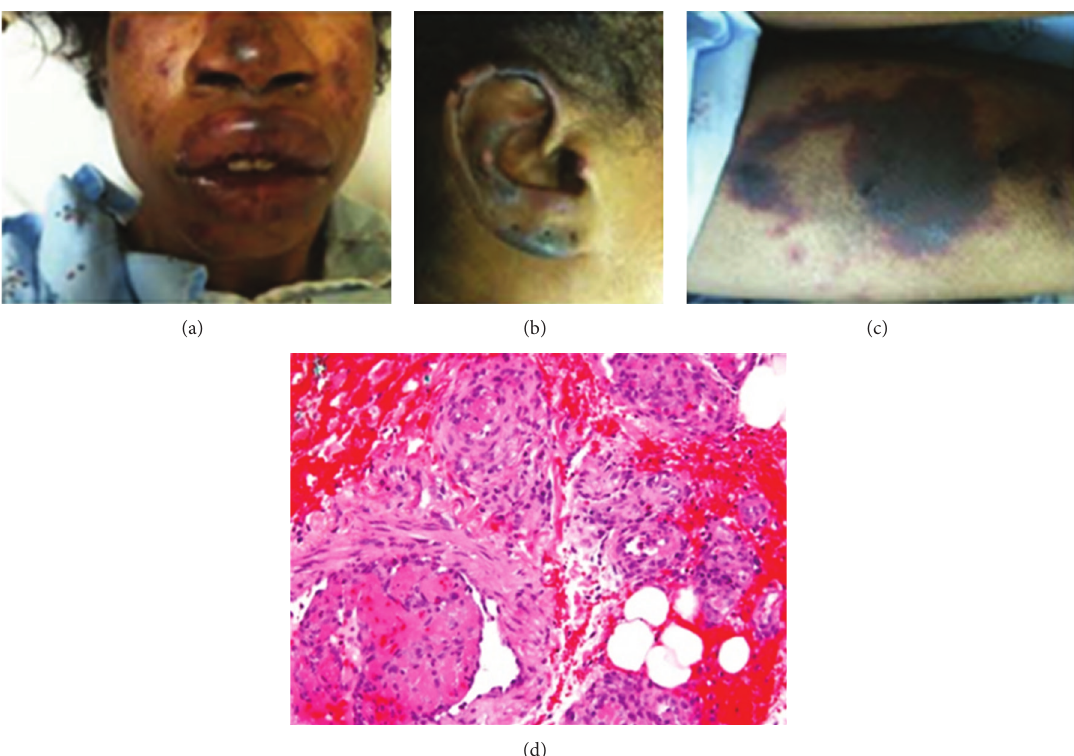
Figure 1: Skin lesions of the (a) face, (b) right ear, and (c) left thigh and (d) skin biopsy of the left thigh showing fibrin thrombin occluding the small-sized vessels with the presence of neutrophils and lymphocytes within the vessel